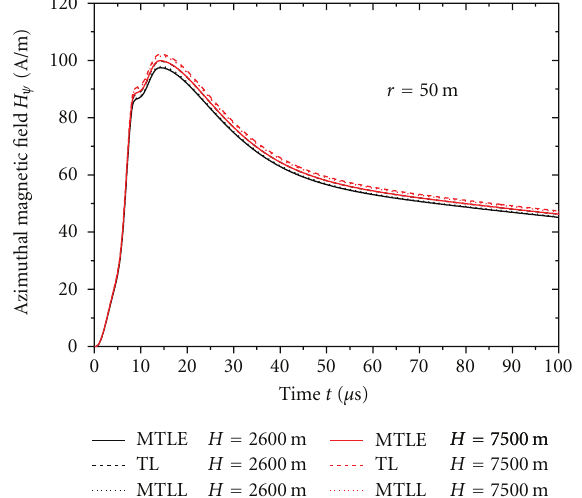
Figure 15: Azimuthal magnetic field at 100km from the channel- base for MSS FST, three di ff erent models and two channel heights ( H = 2600 m and 7500